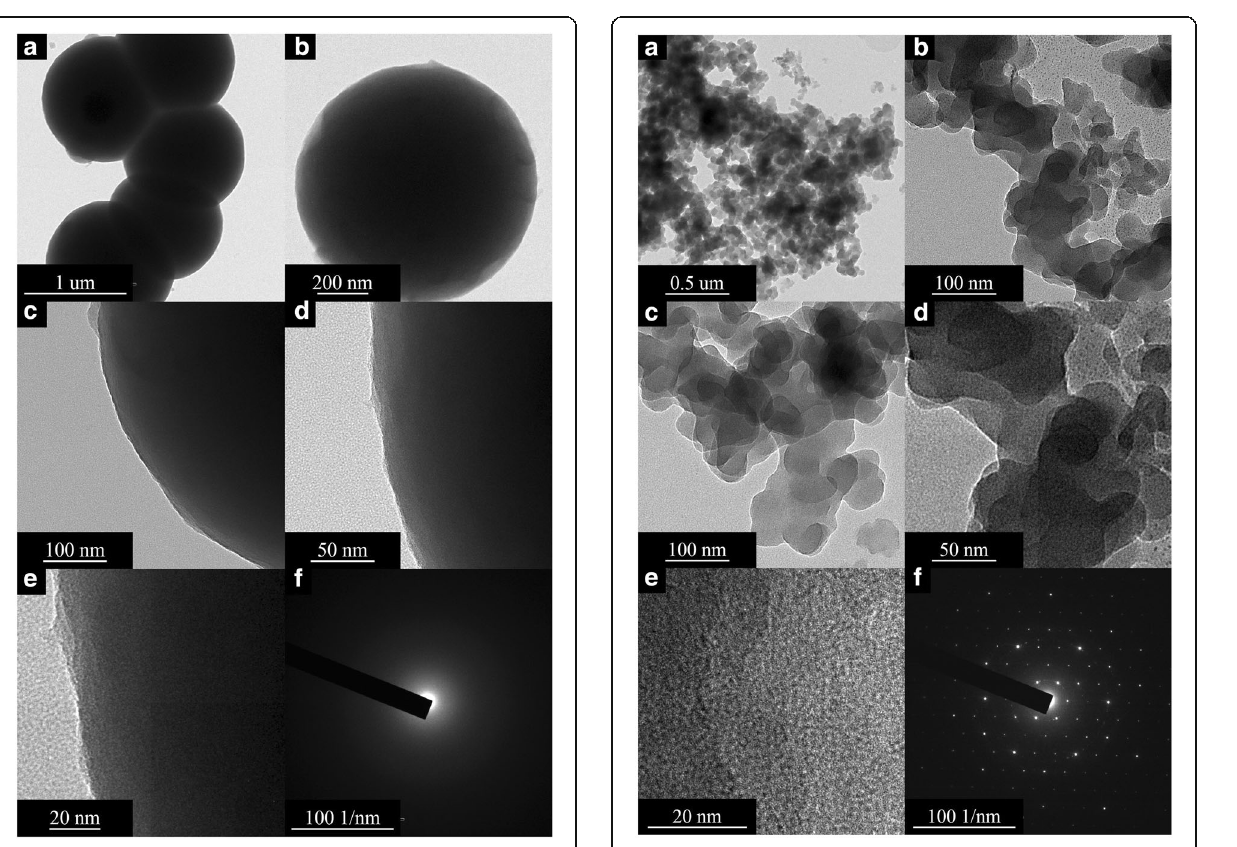
Fig. 8 FE-TEM morphology of cellulose-amino POSS hybrid composite (a-e) sol-gel process (f) SAED pattern